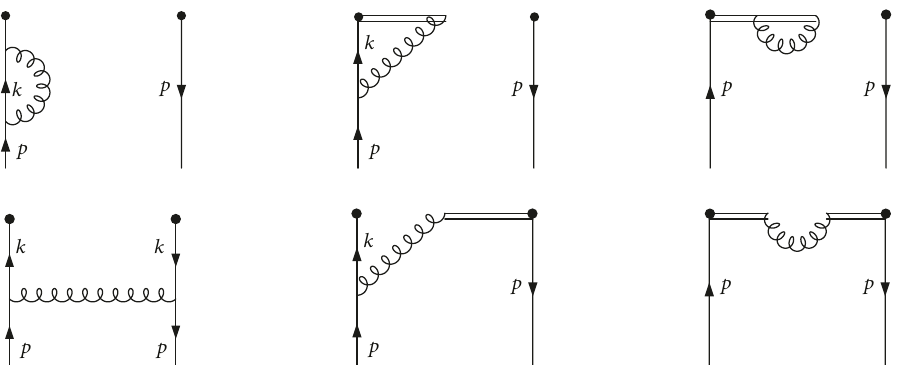
Figure 6: One-loop diagrams entering the quasiquark PDFs in Feynman gauge. Self-energy diagrams are shown in the first row and vertex correction diagrams in the second row. Source: [133], reprinted with permission by the Authors and the American Physical Society.